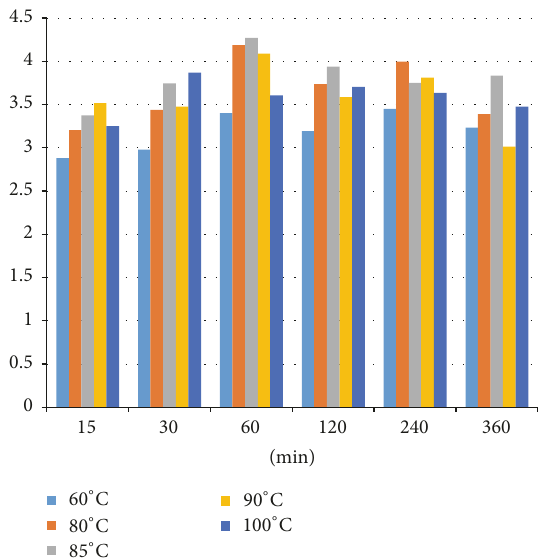
Figure 7: Comprehensive evaluation for the scores of abalone meat.